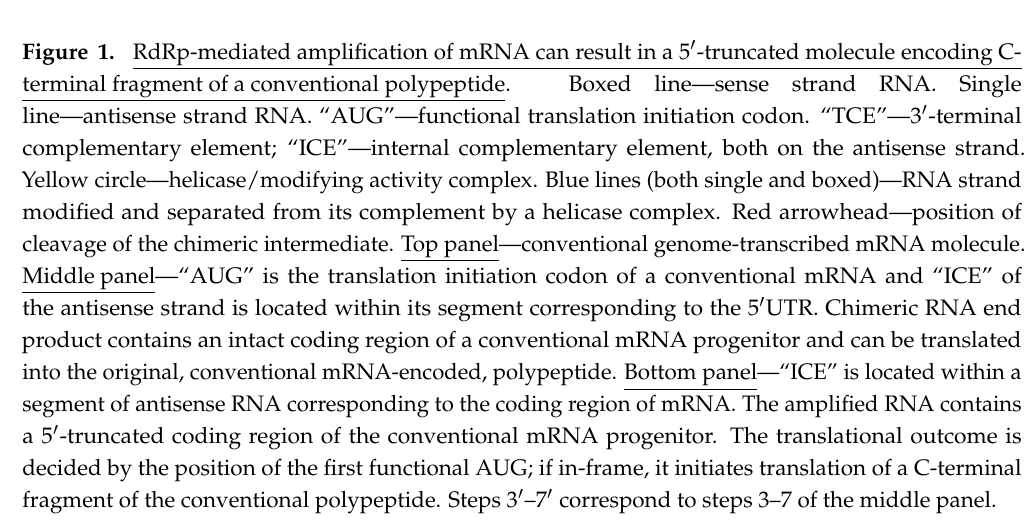
Figure 1. RdRp-mediated amplification of mRNA can result in a 5 (cid:48) -truncated molecule encoding C- terminal fragment of a conventional polypeptide. Boxed line—sense strand RNA.